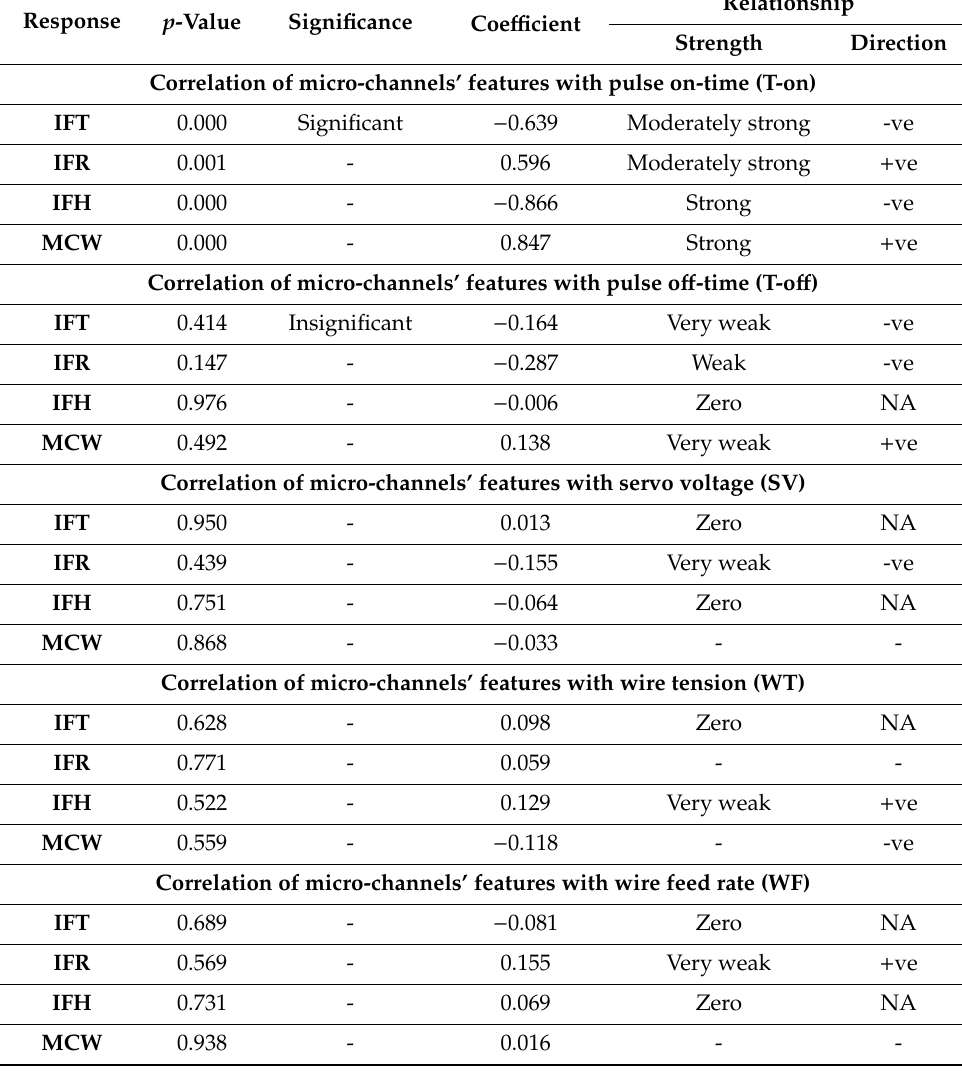
Table 10. Correlation analysis of micro-channels’ attributes with electric discharge machining parameters.